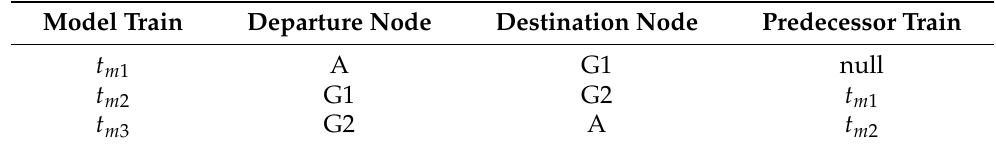
Table 1. Model train